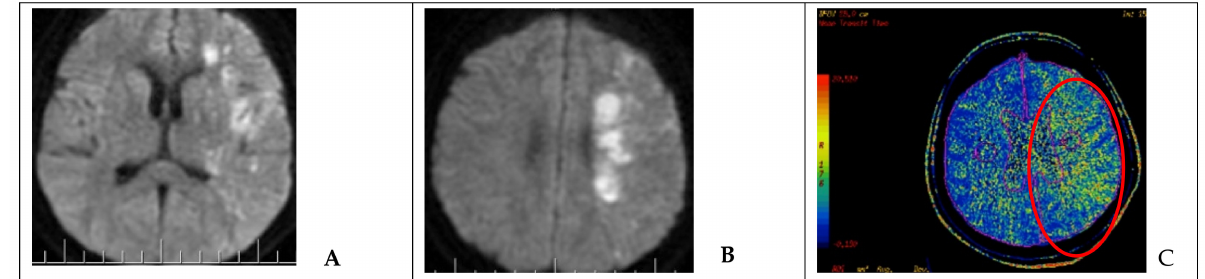
Figure 3. Neuroimaging in a patient after endovascular occlusion of the ICA (clinical case 5). ( A , B ) MRI of the brain (DWI); an area of acute ischemic injury in the left hemisphere (hyperintense area) can be visualized. ( C ) MSCT-perfusion study demonstrating signs of cerebral circulation insufficiency in the form of prolonged blood transit time in the basin of the left MCA (red circled area).